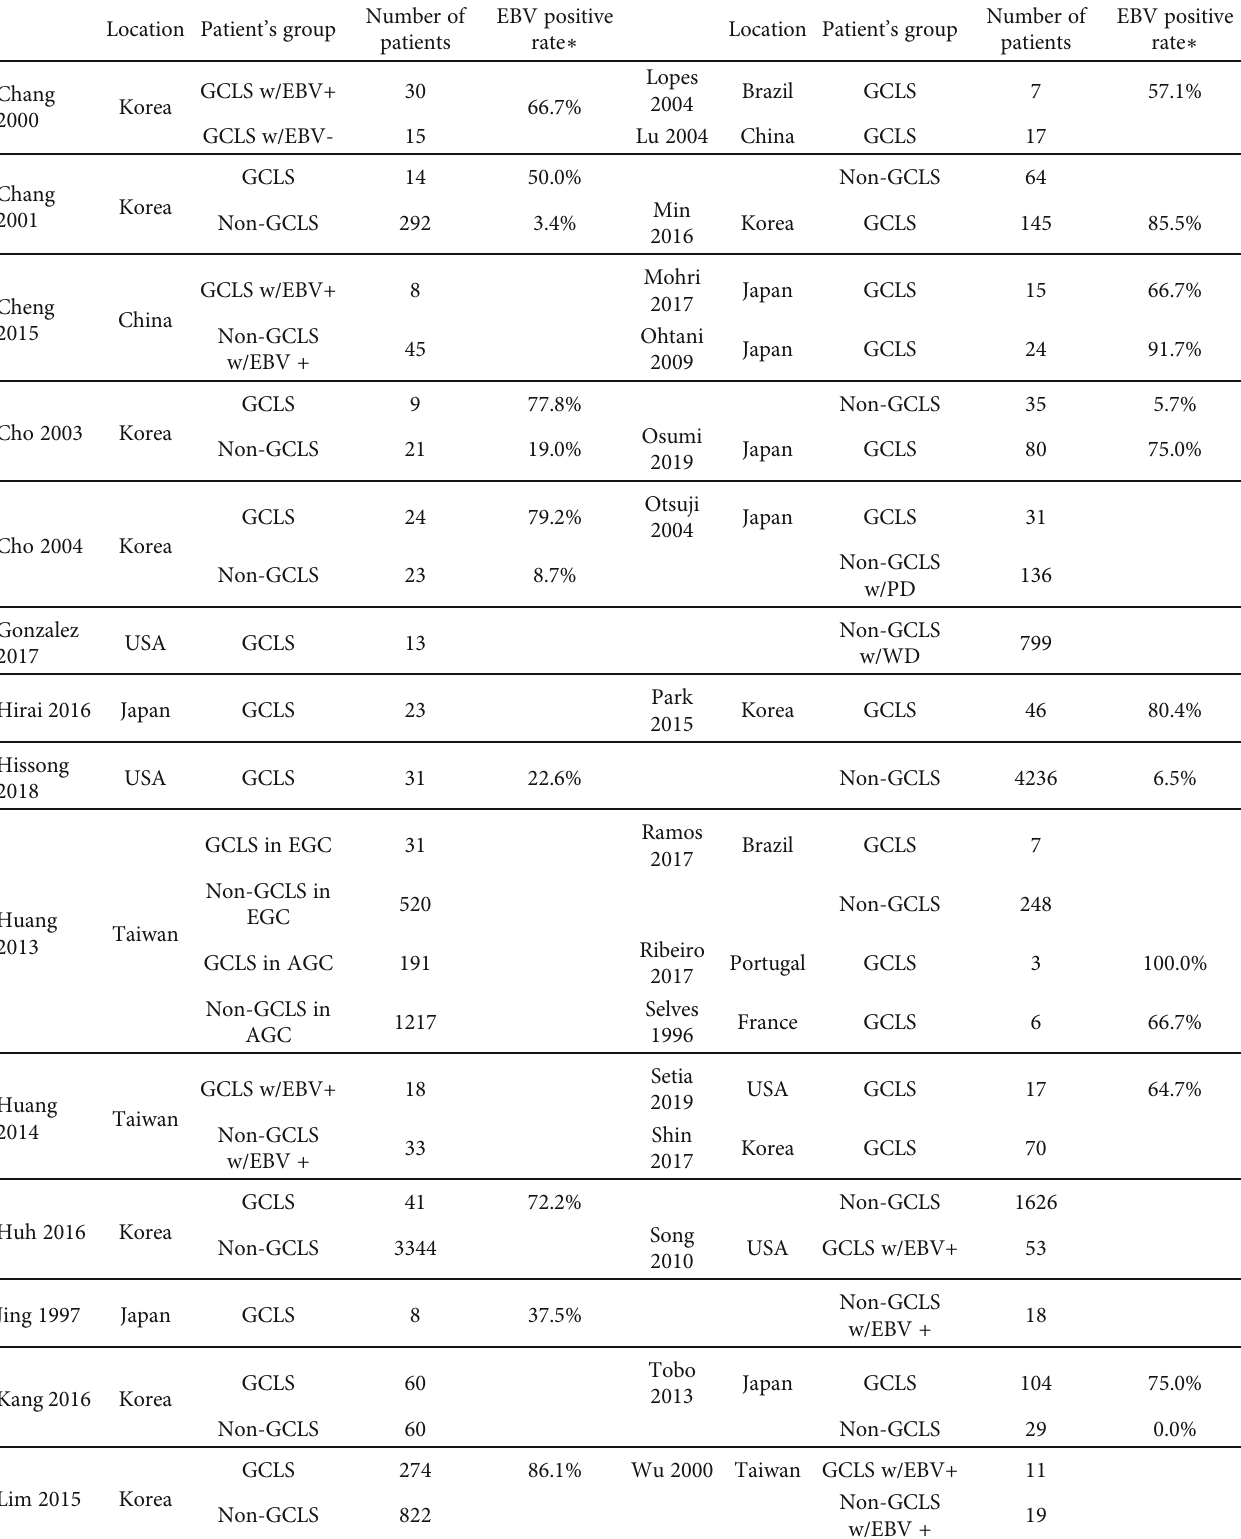
Table 1: Main characteristics of the eligible